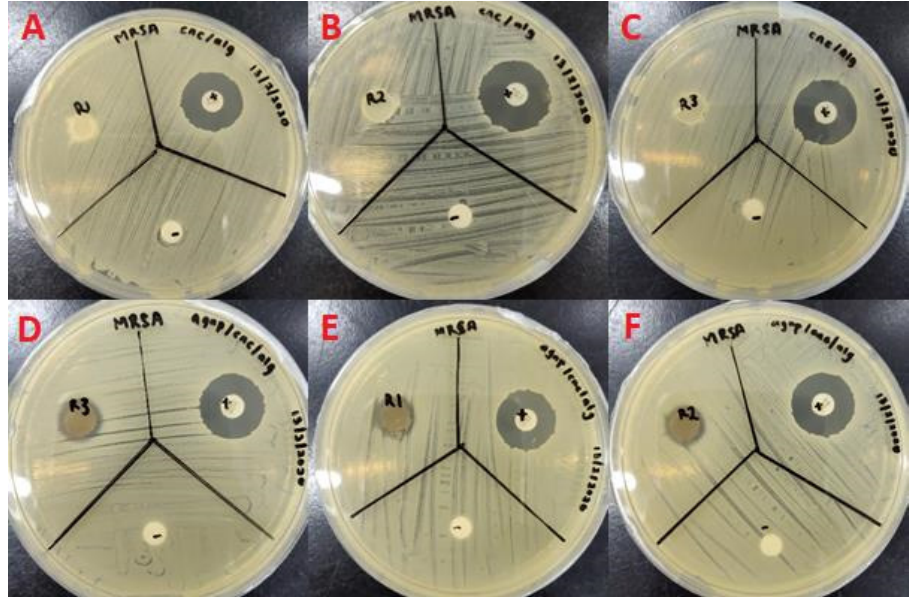
Figure 10. Disc diffusion test of the CNC/Alg hydrogel film ( A – C ) and the bioAgNP-CNC/Alg hy- drogel film ( D – F ) against P. aeruginosa USM-AR2. BioAgNP-CNC/Alg and CNC/Alg are denoted